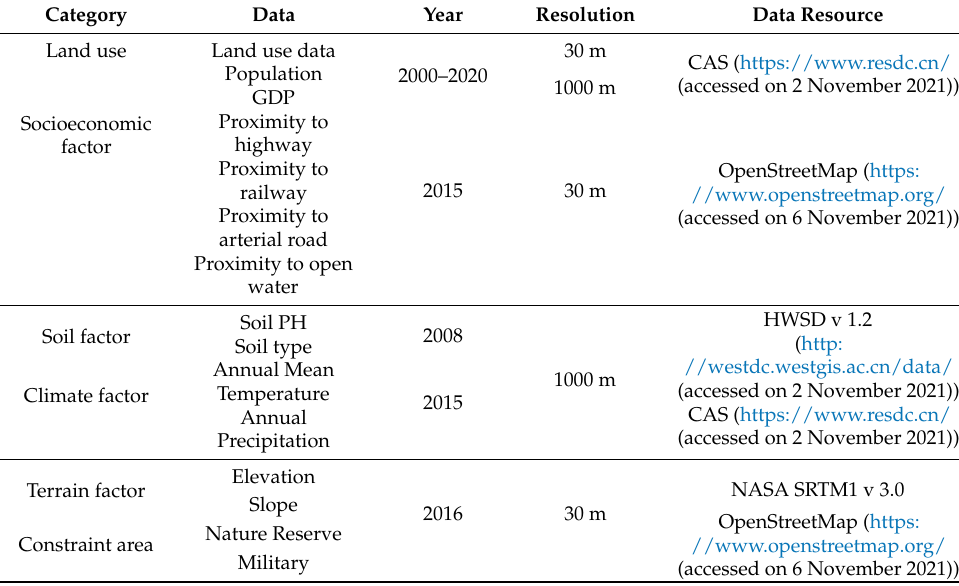
Table A3. The spatial driving factors of the land use change.